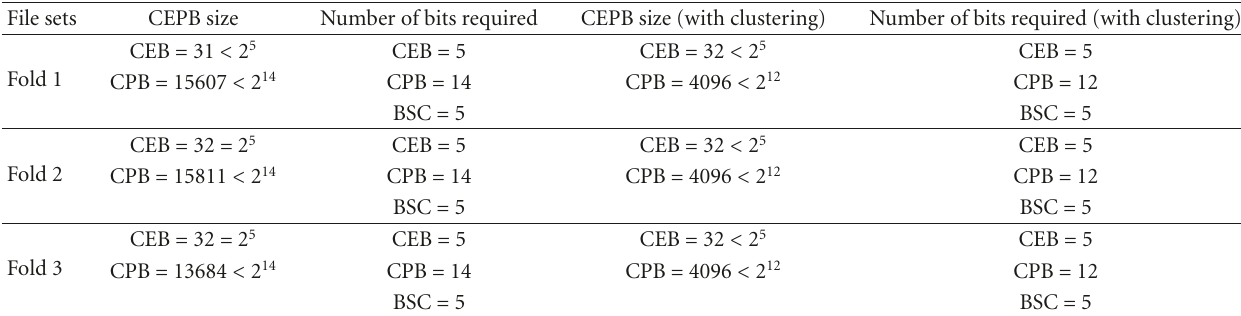
Table 2: Bit allocation table for the first group of